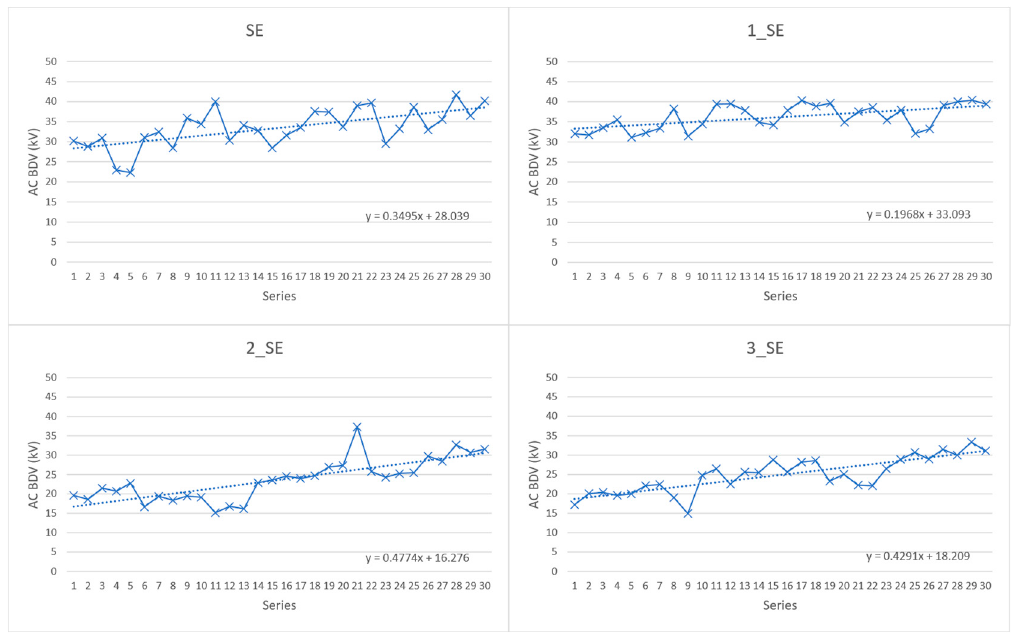
Figure 2. AC BDV distribution of SE-based nanofluids. The symbols indicate individual data points from successive measurements. The experimental data were fitted with a trending linear straight line by the equation displayed in the right bottom corner.